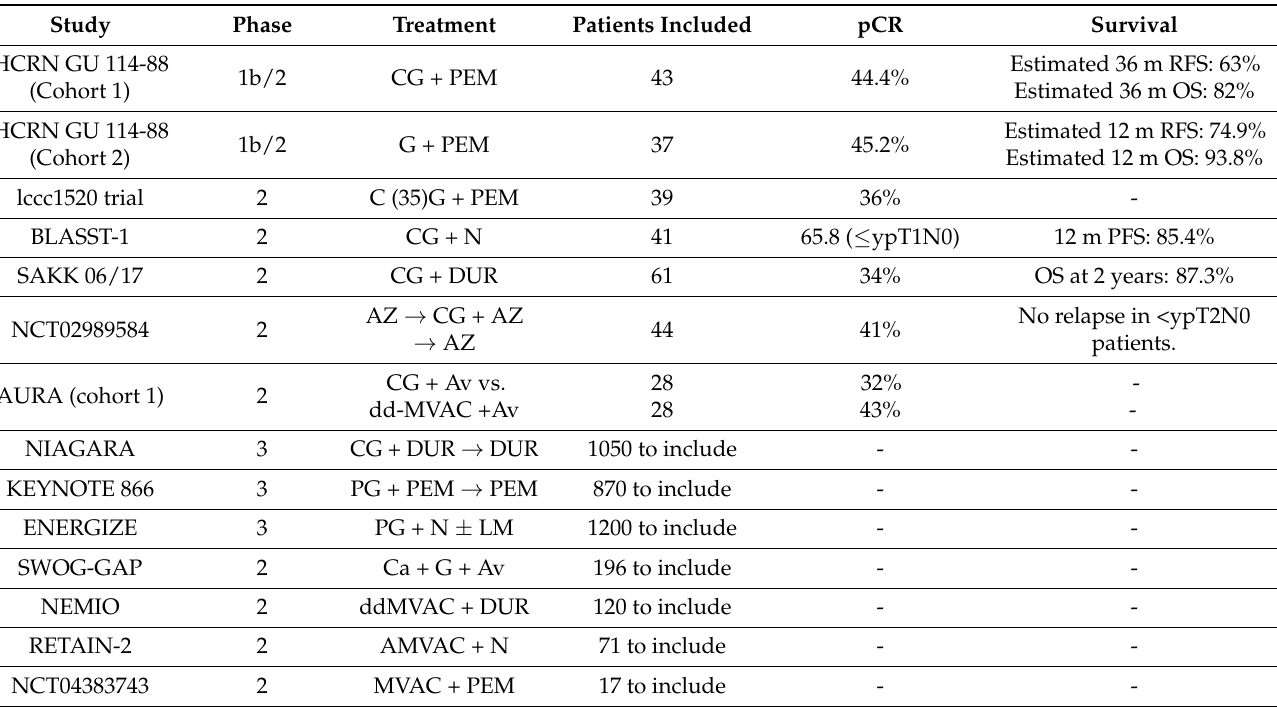
Table 3. Summary of completed, active, or currently recruiting studies with immunotherapy agents in combination with